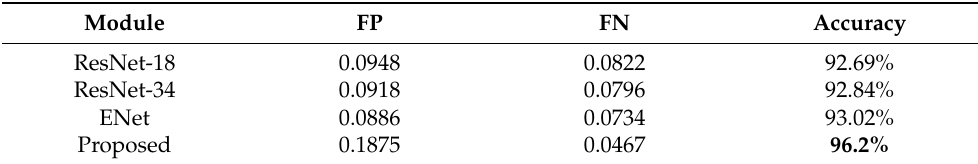
Table 7. Comparison of the performances with different models on TuSimple. The bold scores are the best. Module FP FN